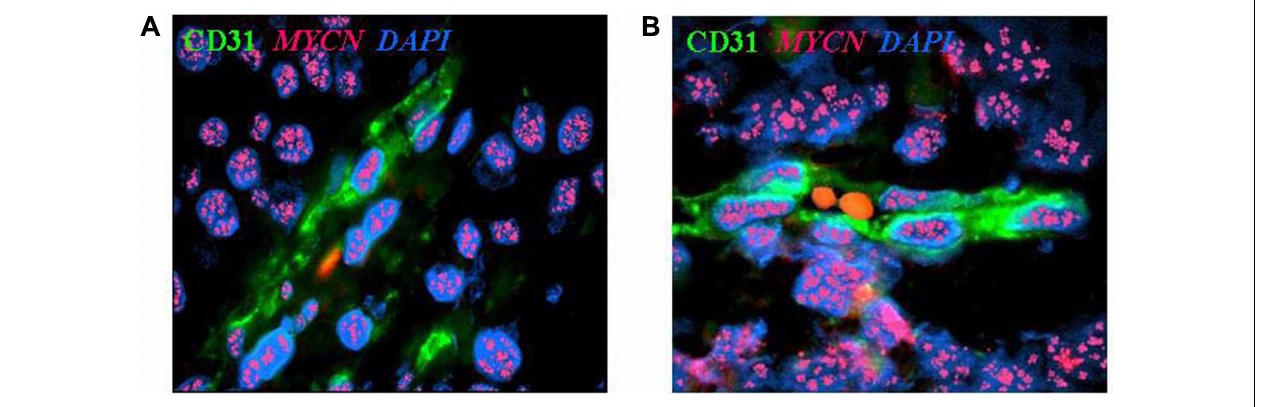
FIGURE 1 | Neuroblastoma-derived endothelial micro-vessels. (A) Immunofluorescence and fluorescent in situ hybridization analysis of NB tumor section highlights CD31 + endothelial micro-vessel (green) carrying